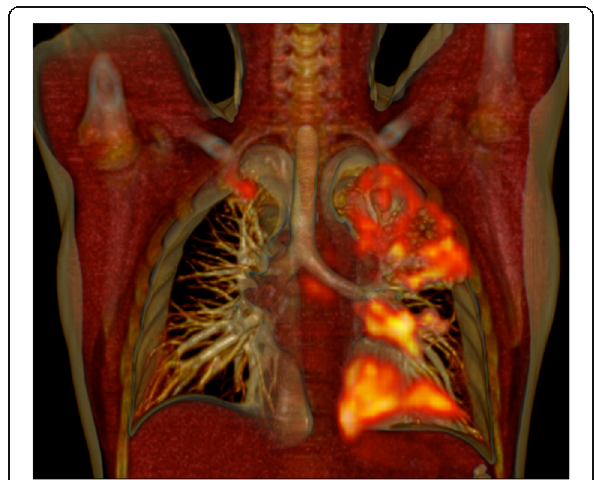
Fig. 1 3D rendered anterior view of fused 18 F-FDG-PET-CT scan, performed at diagnosis on a patient with sputum culture positive pulmonary tuberculosis. It shows a wide distribution of lesions with complex morphology, including a large cavity in the left upper lobe with surrounding nodular infiltrates and patches of consolidation in the left lower lobe